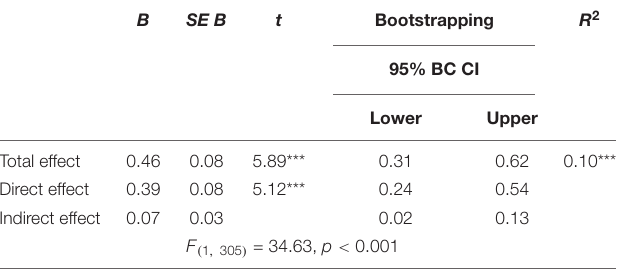
TABLE 3 | Total, direct, and indirect effect of health-promoting collaboration and presenteeism on well-being. B